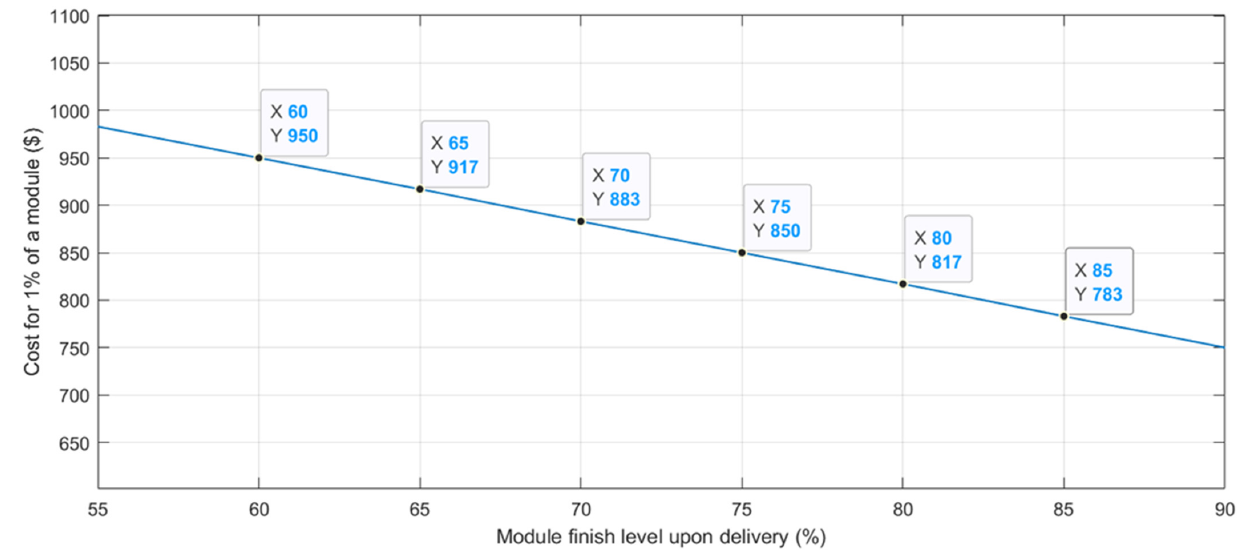
Figure 4. Cost for 1/100 of a module as a function of its finish level upon delivery.